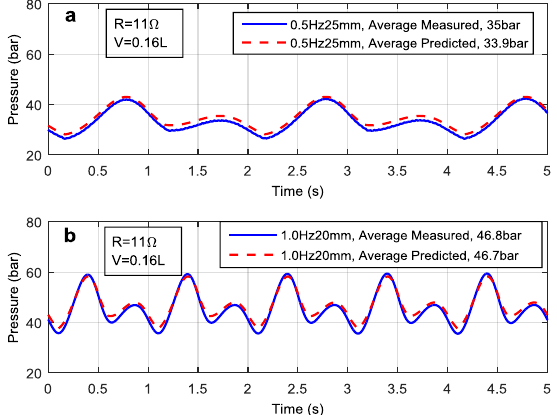
Figure 11. Predicted and measured pressure at ( a ) 0.5 Hz frequency and 25 mm amplitude; and ( b ) 1.0 Hz frequency and 20 mm amplitude ( R is equal to the external load R L and V is the same as accumulator capacity V c ).